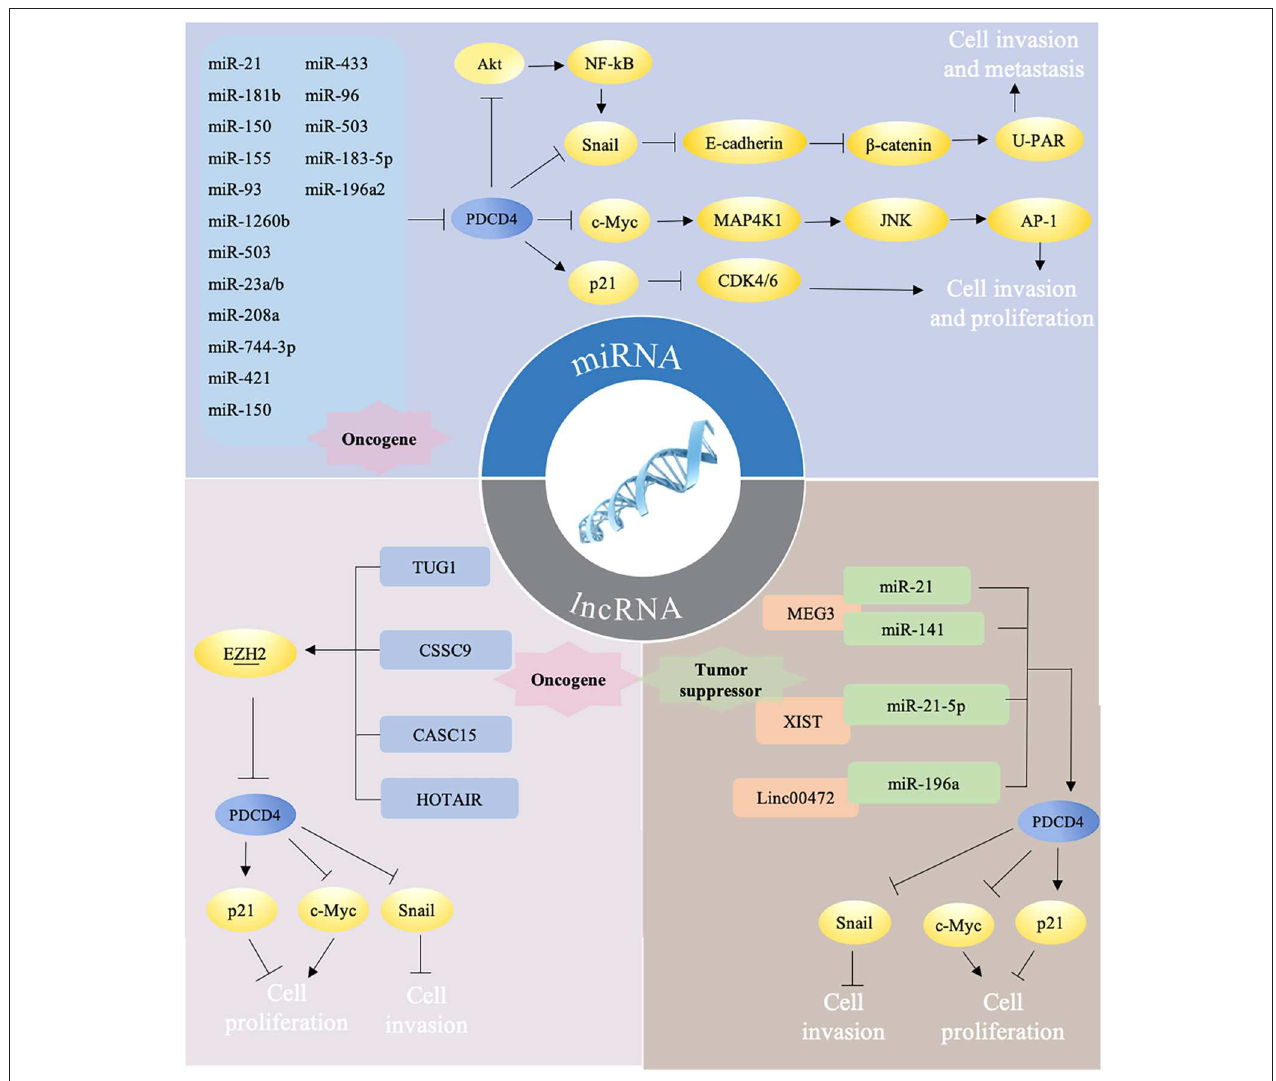
FIGURE 2 | Different ncRNAs regulate PDCD4 in mutiple ways. (i) miRNAs target PDCD4 directly to promote tumor progression via several pathways. Briefly, PDCD4 reduces the expression of Snail directly or by NF- κ B/Akt pathway and leads to up-regulation of E-cadherin, inhibition of β -catenin dependent transcription, and decrease of the expression of c-Myc and uPAR. Down-regulated c-Myc subsequently inhibits MAP4K1 expression, thereby inhibiting AP-1 transcription to impede proliferation, promotion, and invasion. PDCD4 could decrease CDK4/6 via the upregulation of p21, thus leading to reduced cell proliferation. (ii) LncRNAs could function as oncogene and downregulate PDCD4 expression by recruiting EZH2. (iii) LncRNAs could also function as tumor suprefessor to sponge miRNAs, which may counteract the effects of miRNAs on